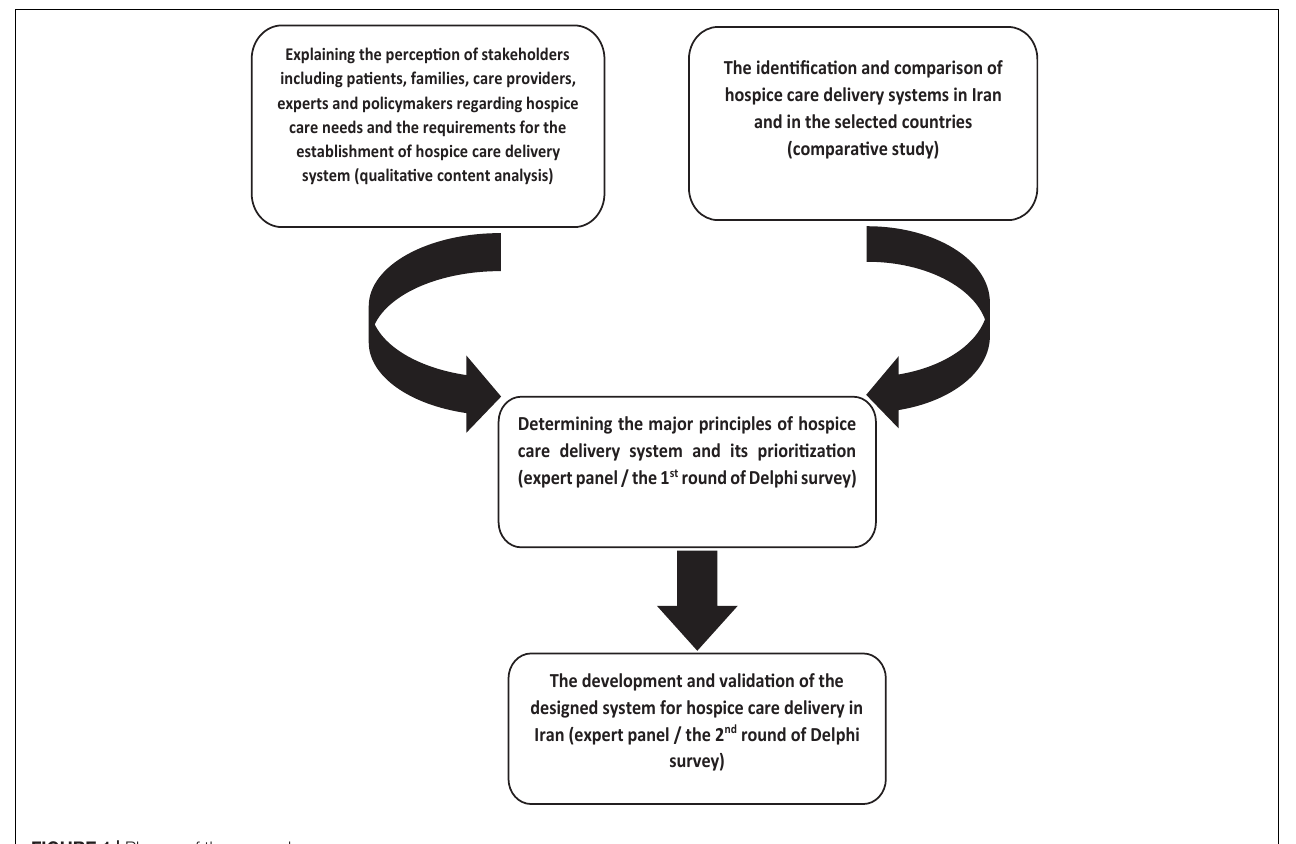
FIGURE 1 | Phases of the